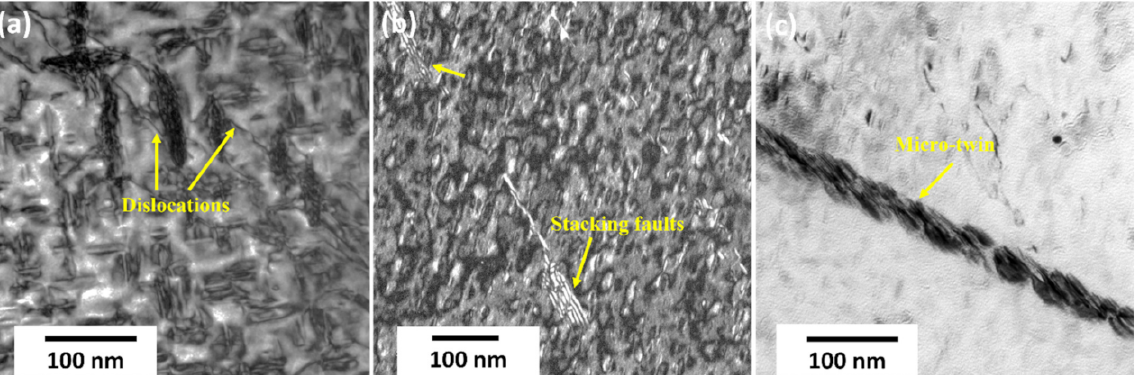
Figure 9. ( a ) TEM micrographs showing shearing of coarse γ ” precipitates by dislocations after the creep test of AB specimen and ( b , c ) the formation of stacking faults and micro-twins after the creep test for the DA specimen.